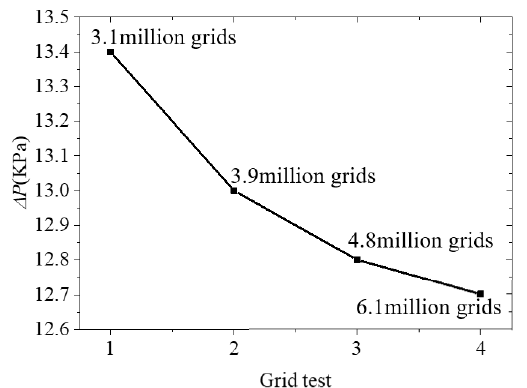
Figure 6. Grid independence test for the fluid region with pressure drop. Case parameters: Re = 10,000.